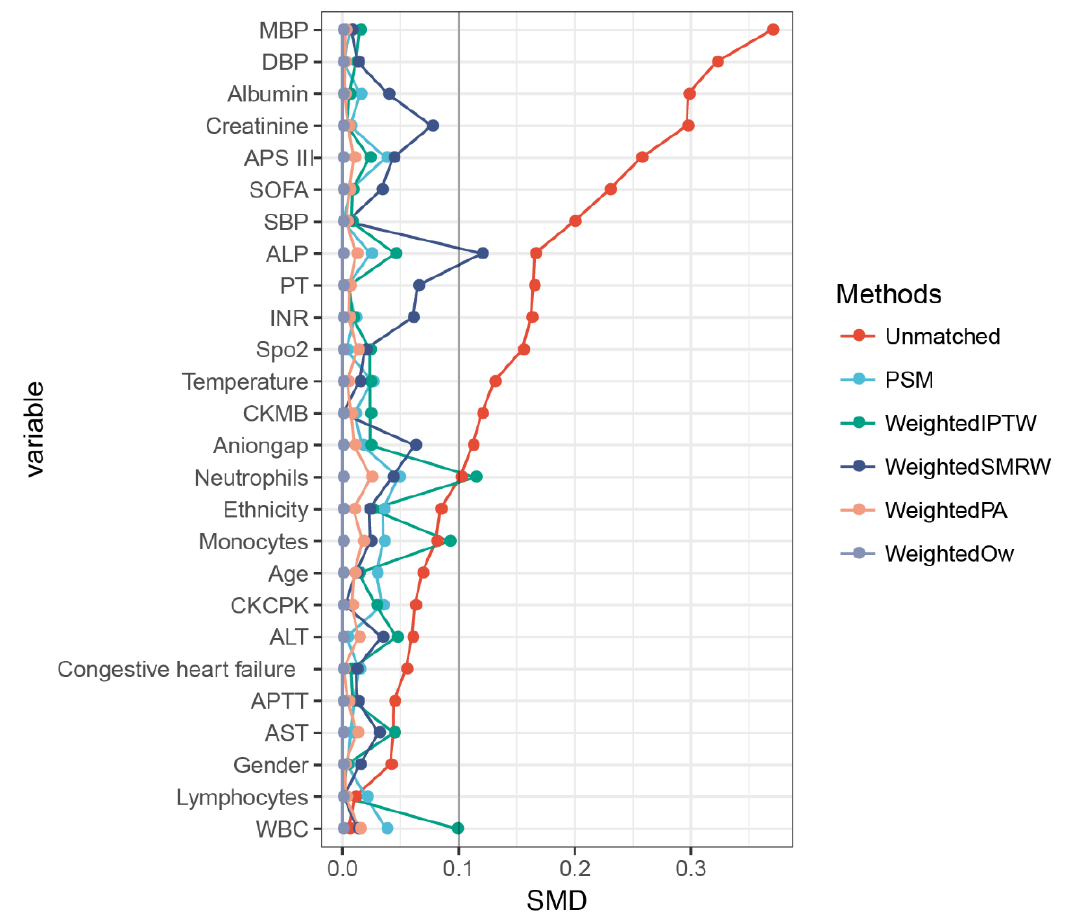
Figure 4. The results of matching. A standardized mean difference (SMD) was used to examine the degree of PSM. A threshold of less than 0.1 was considered acceptable. PSM, propensity score matching [27]; weighted IPTW, weighted the inverse probability of treatment [28]; weighted SMRW, weighted the standardized mortality ratio weighting [28]; weighted PA, weighted pairwise algorithmic [29]; weighted OW, weighted overlap weight [30].